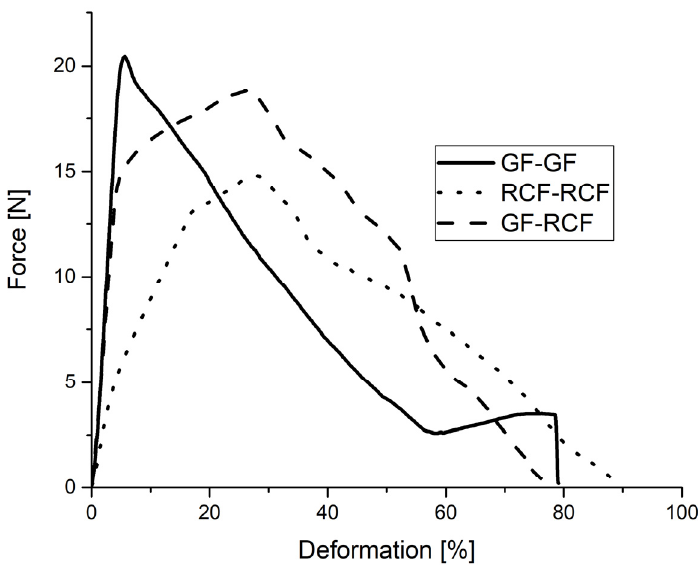
Figure 6. Deformation/Force course of hybrid and reference samples in fiber pull-out tests.